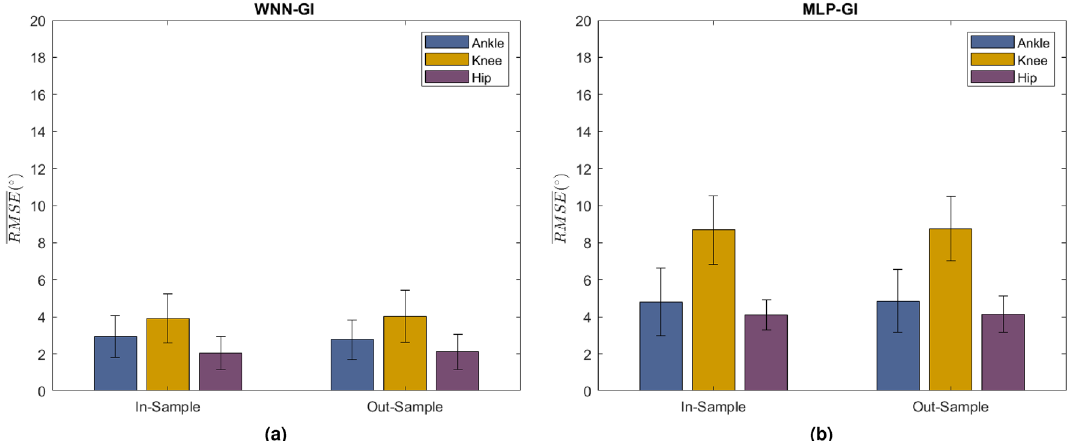
Figure 2. RMSE ( mean ± standard deviation ) for In-Sample and Out-Sample estimations corresponding to ankle, knee, and hip angles. ( a ) WNN-GI and ( b ) MLP-GI. Accuracies correspond to the data sequence 1, which reported the least RMSE . All networks are trained with five hidden layer nodes and 50 epochs. More details of accuracies are documented in Tables 2–7, in Supplementary